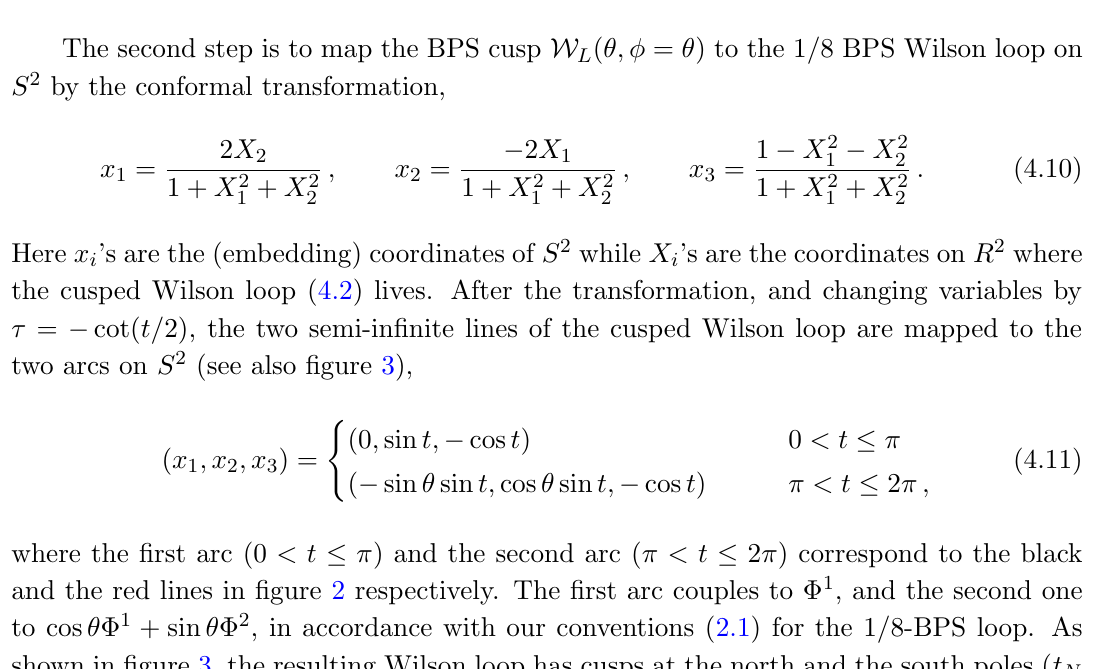
Figure 3 . Cusped Wilson loop on S 2 . Applying the conformal transformation, one can map the cusped Wilson line to a con(cid:12)guration depicted above. The red and black semi-circles correspond to the two semi-in(cid:12)nite lines in (cid:12)gure 2 of the same color. The angle between the two semi-circles is (cid:25) (cid:0) (cid:18) . The loop divides the S 2 into two regions with areas 2 (cid:25) (cid:7) 2 (cid:18) . (Note that we already set (cid:30) = (cid:18) in this